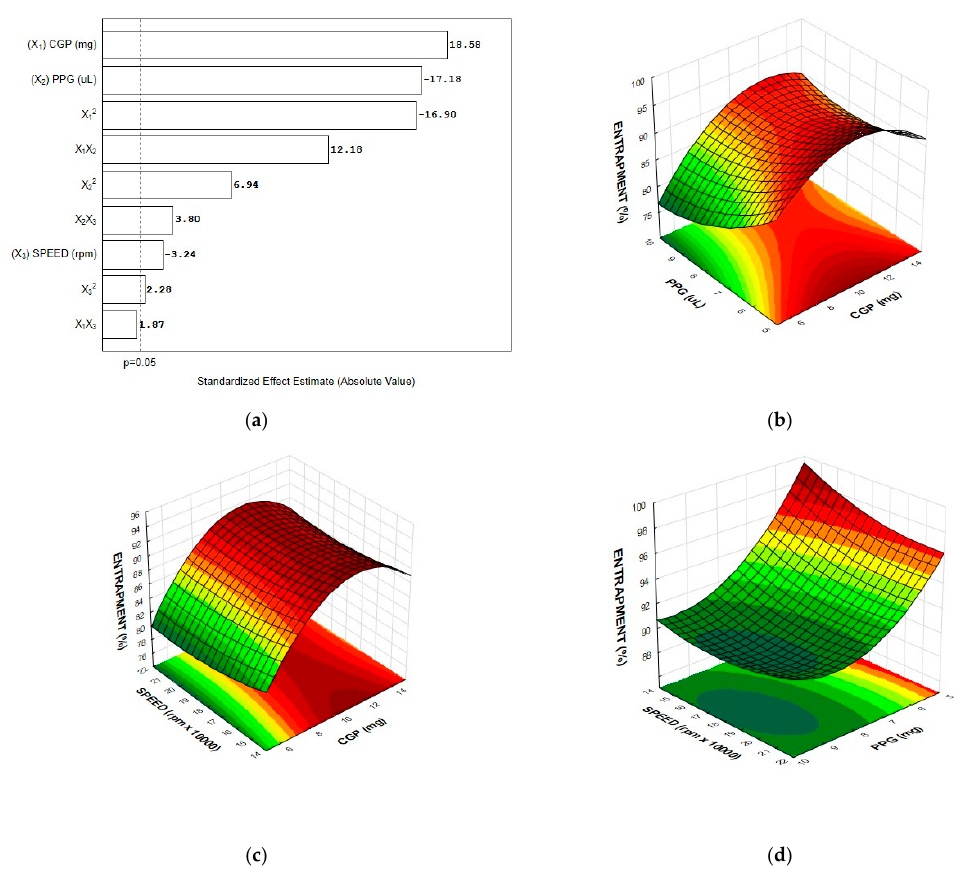
Figure 2. Pareto chart ( a ) and response surface plot for diclofenac entrapment efficiency as a function of ( b ) CGP content and PPG volume; ( c ) CGP content and homogenization speed; and ( d ) PPG volume and homogenization speed ( n = 6 replicates).